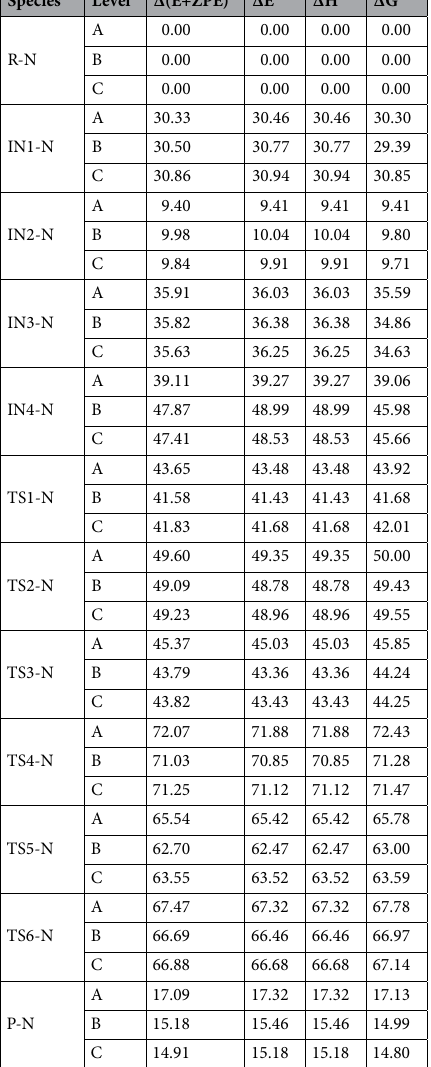
Table 1. Relative energies corrected by ZPE, thermal energies (ΔE°), enthalpy energies (ΔH°), and Gibbs free energies calculated for all stationary points of 3-hydroxyl-1H-pyrrol-2(5H)-one unimolecular reaction at different levels. A, B, and C are CBS-QB3, M06-2X/Jun-cc-pVTZ, and M06-2X/6-311+g(2df,2p) levels,